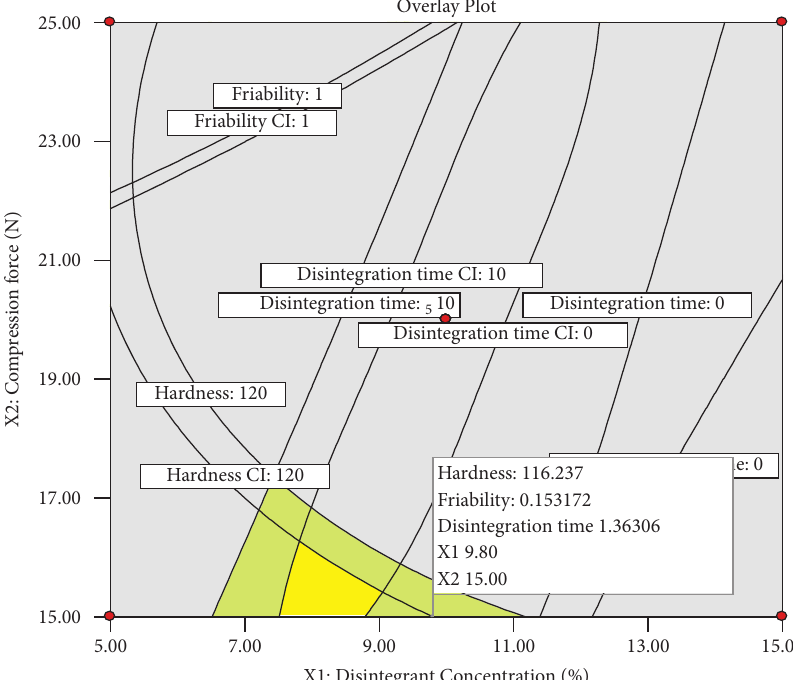
Figure 6: Superimposed contour plots of the responses of the tablets as a function of the